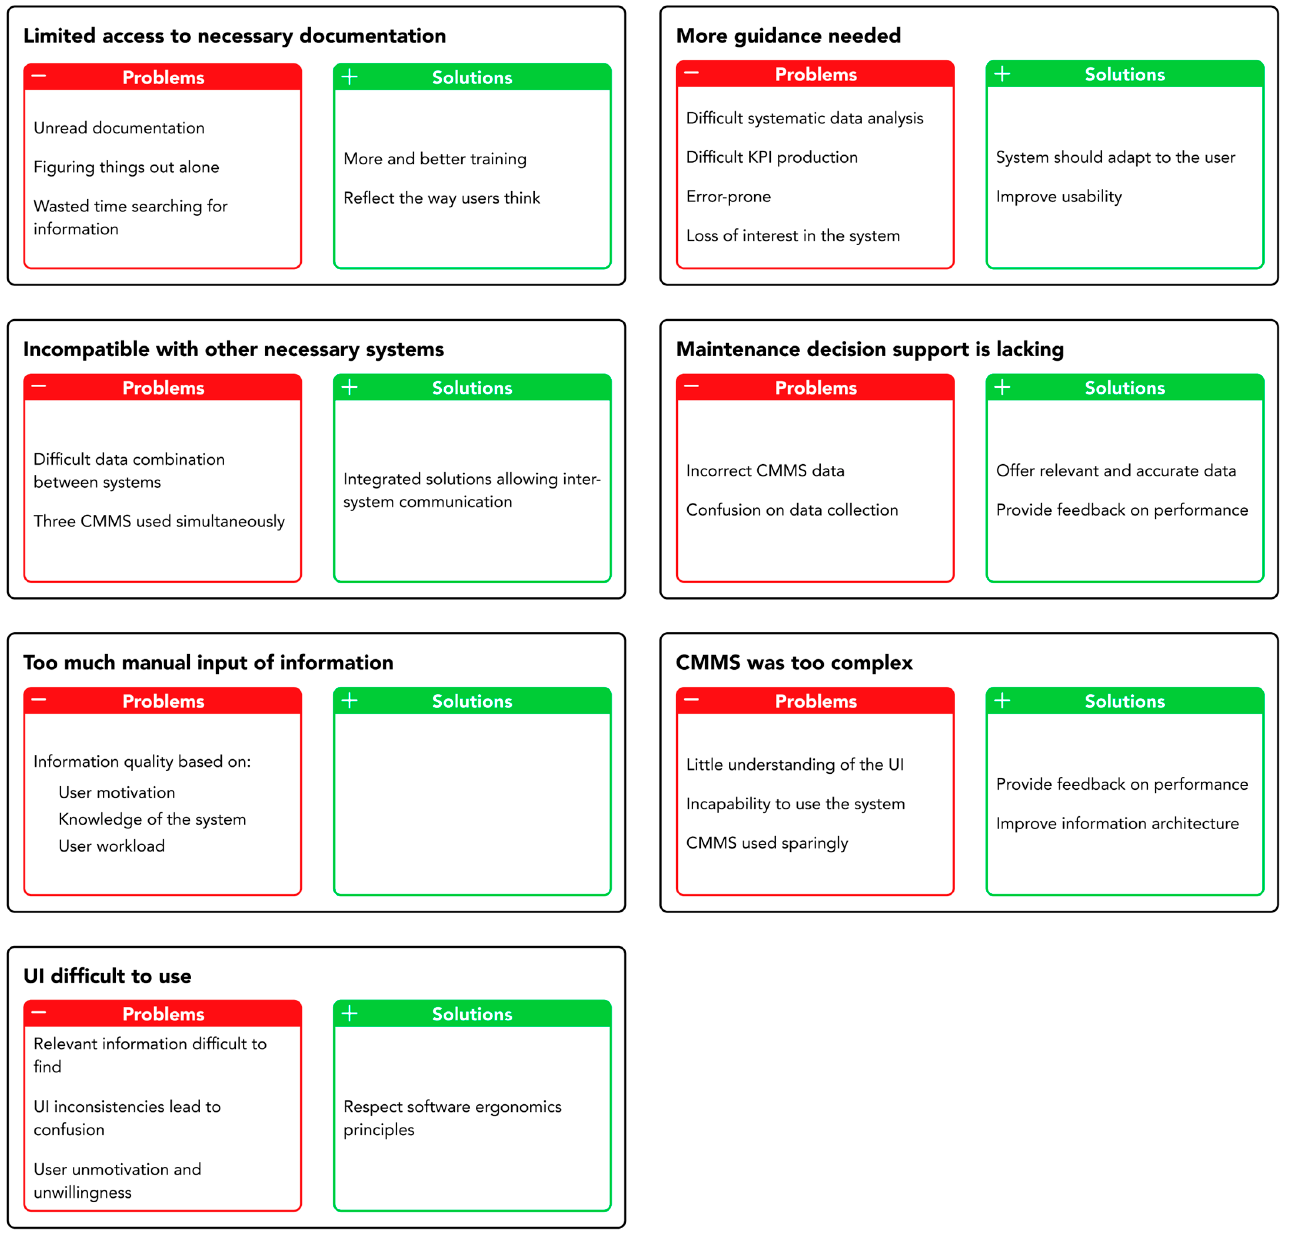
Figure 3. Industry CMMS needs and recommendations based on